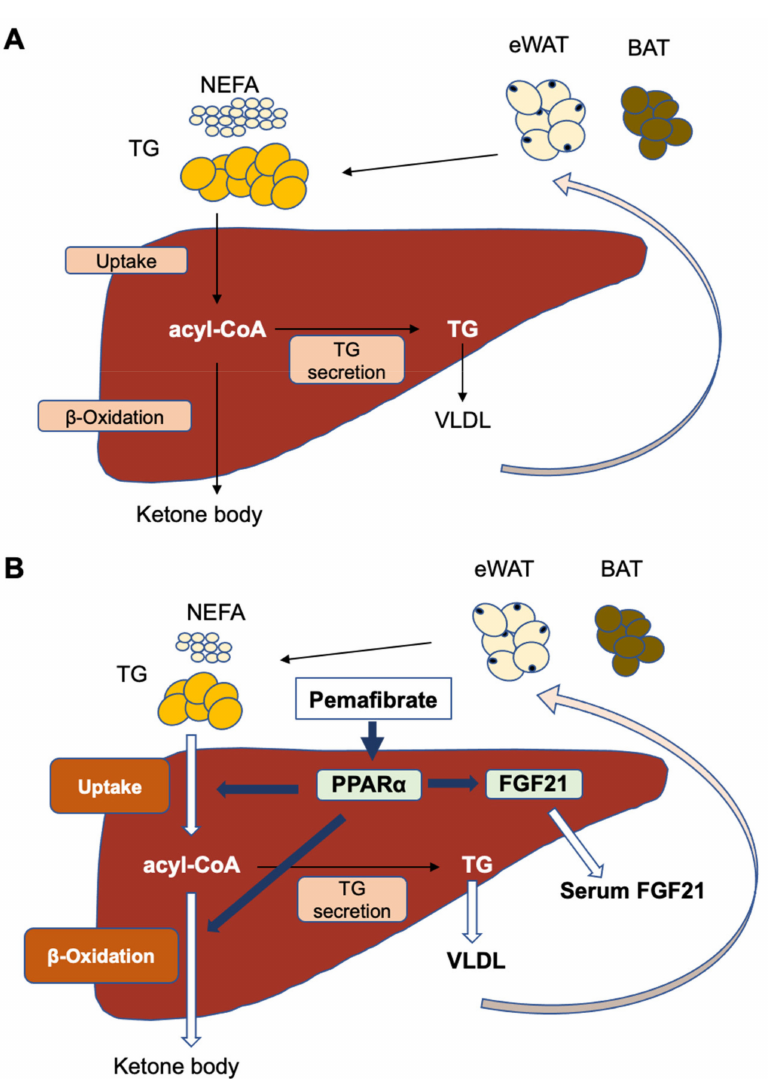
Figure 9. Proposed pharmacological effect of PEM in the clinical setting. ( A ) Constitutive FA/TG metabolism. ( B ) Clinically relevant dose of PEM targets hepatic PPAR α to enhance the uptake of non-esterified fatty acid (NEFA) and FA β oxidation in the liver. PEM also promotes hepatic MTP expression, thus accelerating TG secretion from the liver into the systemic circulation. Additionally, PEM increases circulating FGF21 by augmenting FGF21 production in the